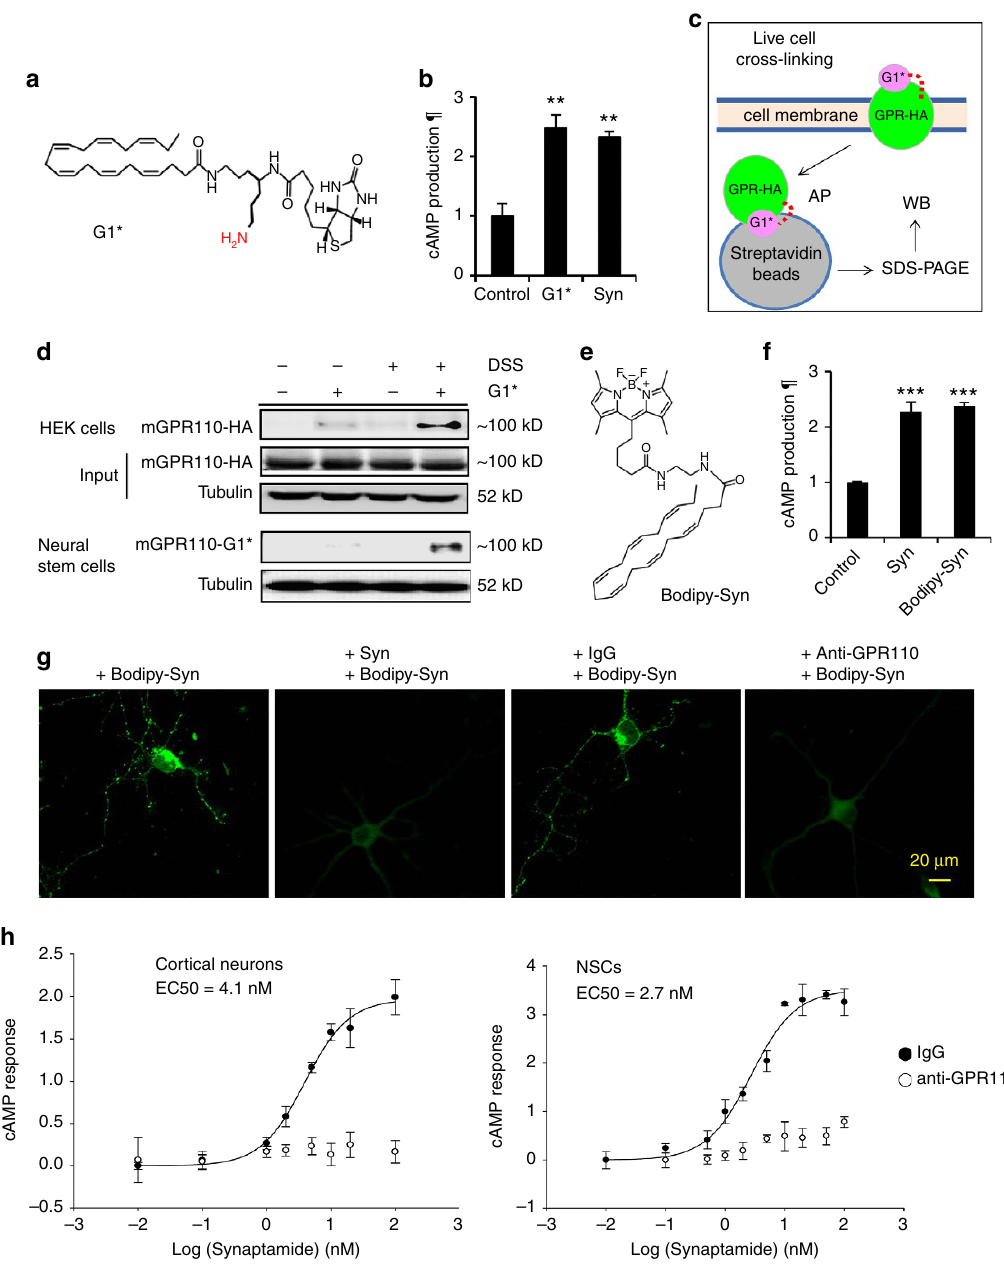
Figure 3 | Synaptamide binding to GPR110 in living cells identified by in-cell cross-linking/affinity purification or fluorescence microscopy. Chemical structure of the biotinylated synaptamide analogue (G1*) containing a cross-linkable primary amine group ( a ). G1* and synaptamide at 10nM similarly induced cAMP production in DIV3 cortical neurons after a 10-min incubation ( b ). Strategy to detect G1* bound-GPR110 in living cells ( c ). The G1*-receptor complex stabilized by DSS cross-linking was detected by anti-HA antibody for GPR110-HA-expressing HEK cells or peroxidase conjugated streptavidin for endogenous GPR110 in NSCs. The control was treated with biotin instead of G1* ( d ). Chemical structure of bodipy-synaptamide ( e ). Similar to synaptamide, bodipy-synaptamide at 10nM increased cAMP production in DIV3 cortical neurons after a 10-min incubation ( f ). Confocal images of fluorescent endocytic receptor puncta detected after incubating DIV3 cortical neurons with bodipy-synaptamide (100nM) for 30min ( g ). Only weak non-specific signal without fluorescent puncta were observed after the pretreatment with anti-GPR110 antibody (0.4 m gml (cid:2) 1 ) or synaptamide (10nM) for 30min, indicating specific binding of synaptamide to GPR110 on the surface of live cortical neurons ( g ). Synaptamide dose-dependently increased cAMP production in cortical neurons and NSCs with EC 50 in the low nM range (closed circle), which was blocked by 30min pretreatment with GPR110 antibody at 0.4 m gml (cid:2) 1 (open circle) ( h ). DSS: disuccinimidyl suberate. Data represent two ( d , h ), three ( b , f ) or six ( g ) independent experiments. Values in ( b , f , h ) are means ± s.e.m. of biological triplicates ( n ¼ 3). ** P o 0.01, *** P o 0.001 versus control by unpaired Student t -test. z , relative to control. Scale bar, 20 m m ( g the N -terminal targeting GPR110 antibody described above or by cAMP (Fig. 5a), CRE transcriptional activity (Fig. 5b) and neurite GPR110 gene silencing or overexpression (Fig. 5). Blocking outgrowth (Fig. 5c,d). Similarly, synaptamide-induced cAMP GPR110 by pretreatment of cortical neurons with the GPR110 production and neurogenic differentiation of NSCs was diminished antibody for 30 min prevented a synaptamide-induced increase in after pretreatment with the same GPR110 antibody while the